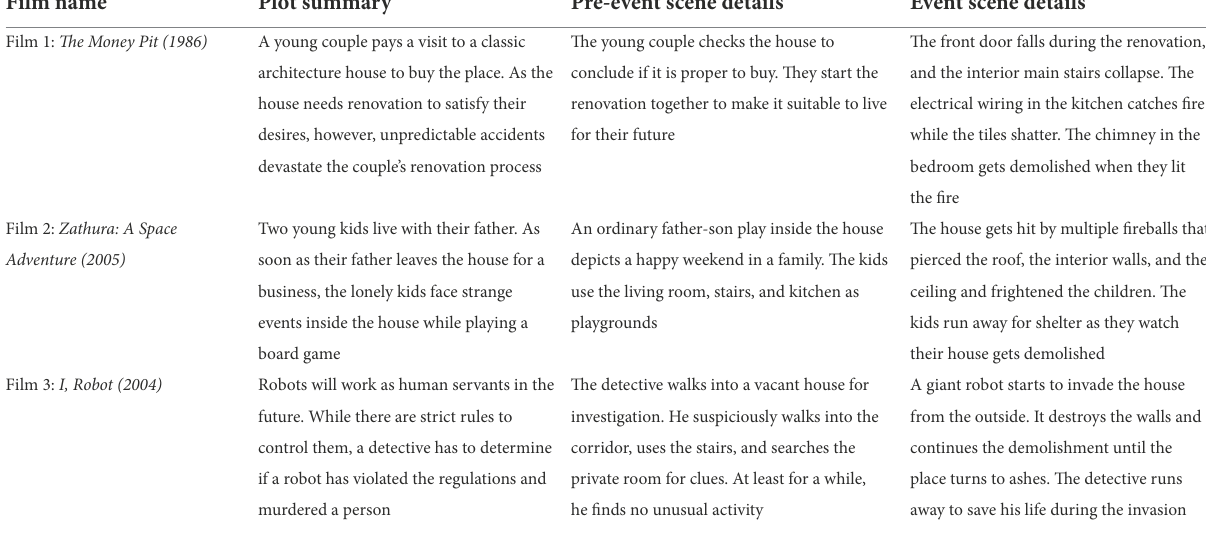
TABLE 2 Plot summaries and space-related features in the film